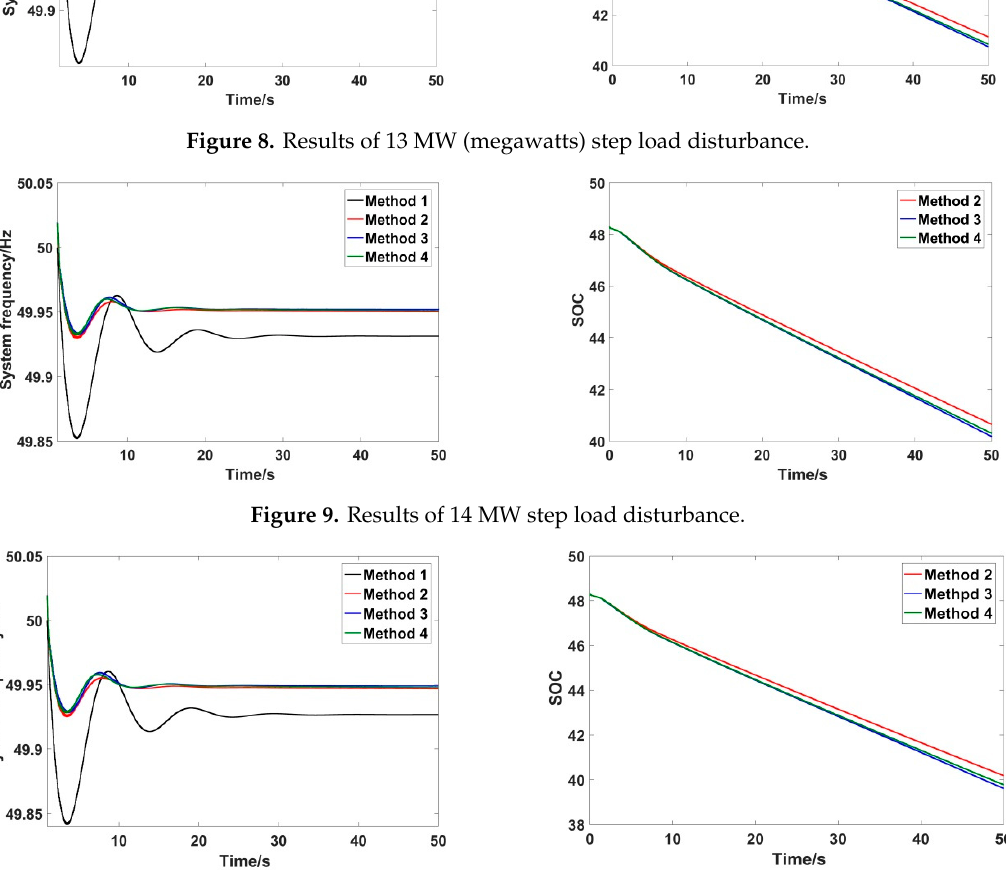
Figure 10. Results of 15 MW step load